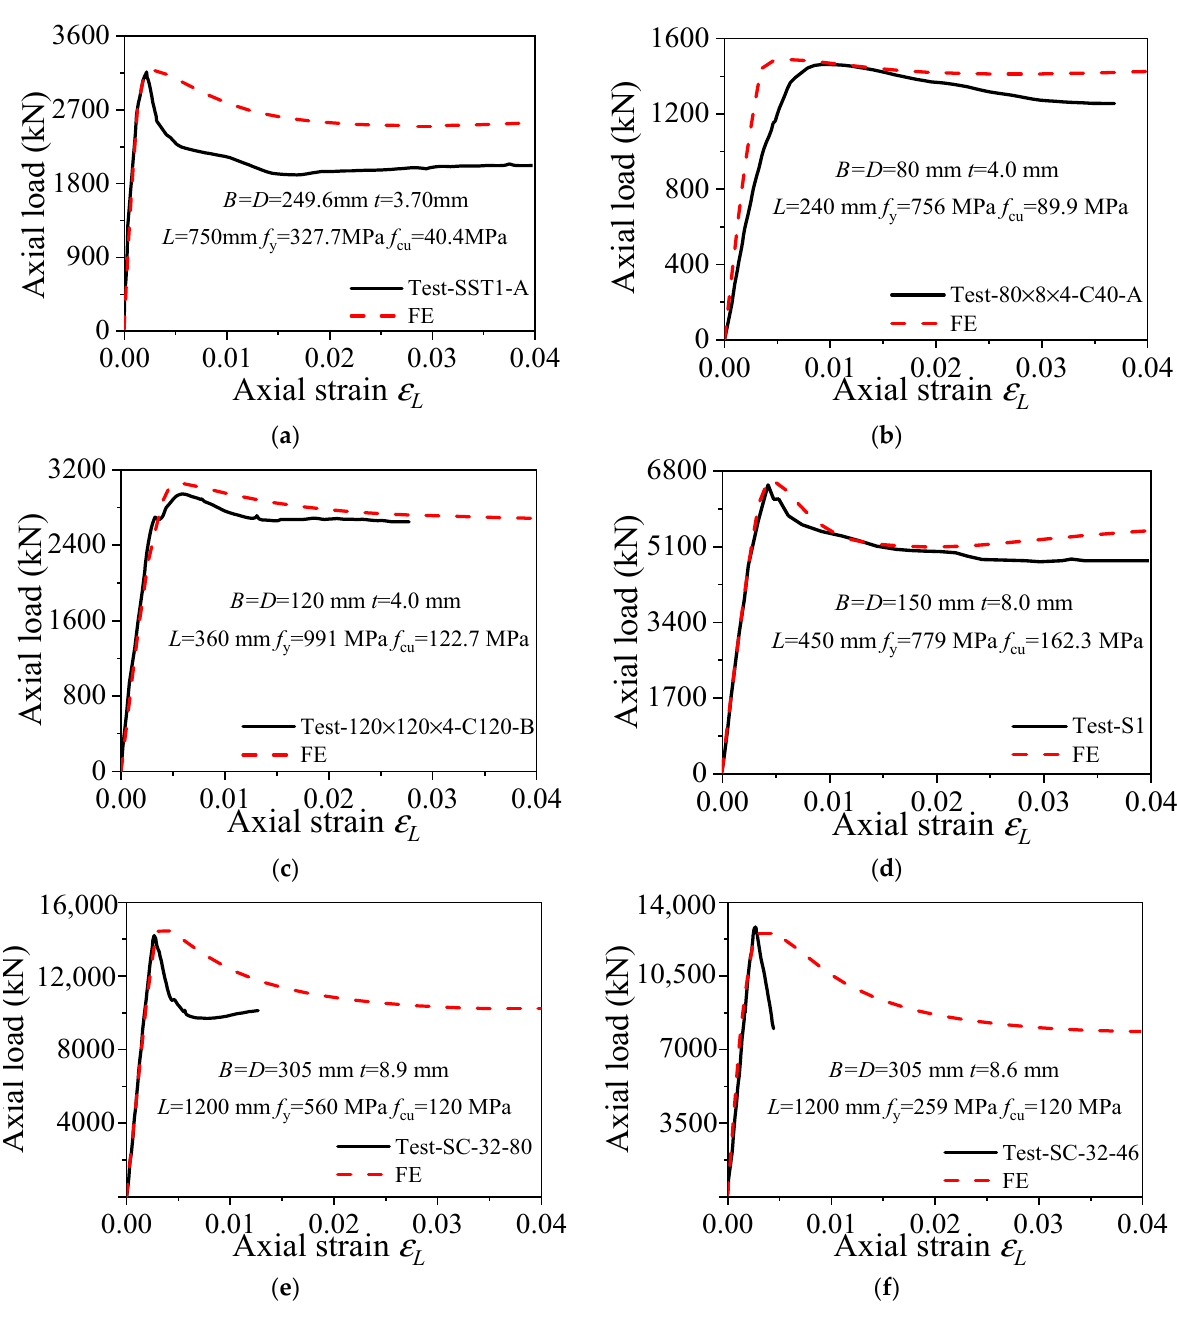
Figure 5. Comparison of FE and experimental load–strain curves of HSCFST. ( a ) Test-SST1-A [27]; ( b ) Test-80804-C40-A [20]; ( c ) Test-1201204-C120-B [20]; ( d ) Test-S1 [28]; ( e ) Test-SC-32-80 [29]; ( f ) Test-SC-32-46 [29].